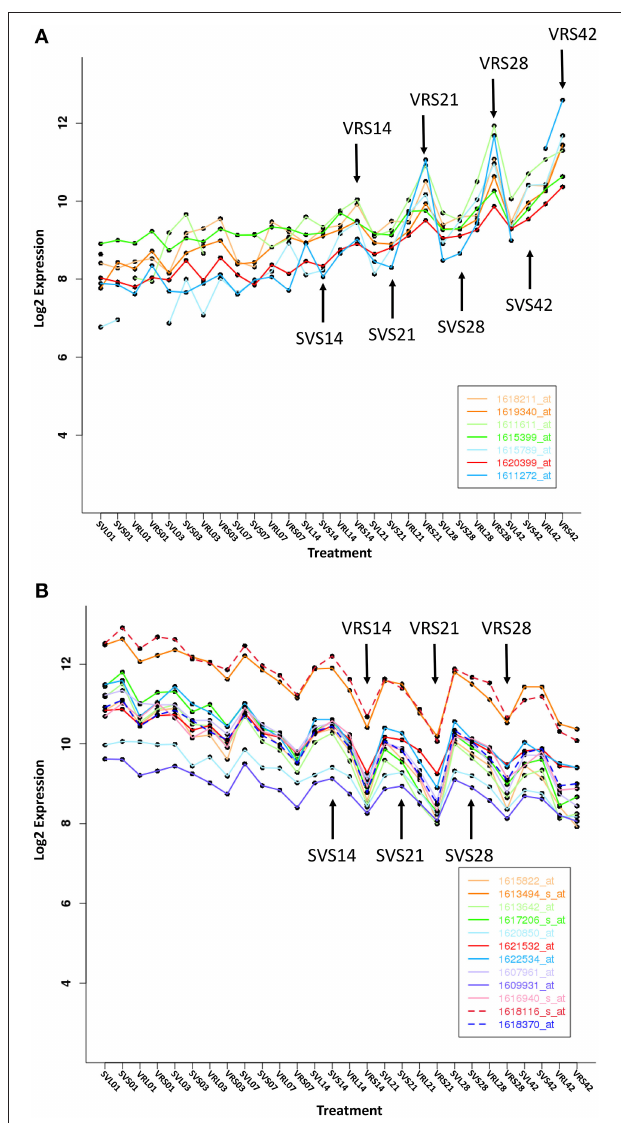
FIGURE 4 | Expression patterns for representative genes that are significantly up- or down-regulated at one or more time point in V. riparia (VR) or Seyval (SV). (A) Up-regulation gene expression pattern in response to short day treatment (VRS, SVS). (B) Down-regulation expression pattern in response to short day treatment. Expression values are log2-transformed means across replicates after normalization ( n = 6 ). Arrows indicate VRS and SVS expression responses that were not similar during dormancy